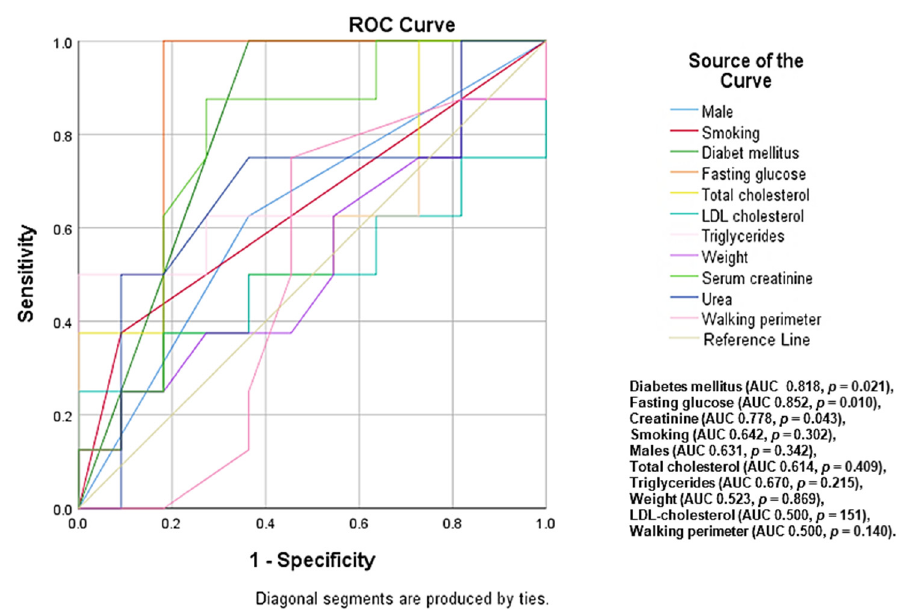
Figure 2. Predictors associated with a high risk mortality rate at 10